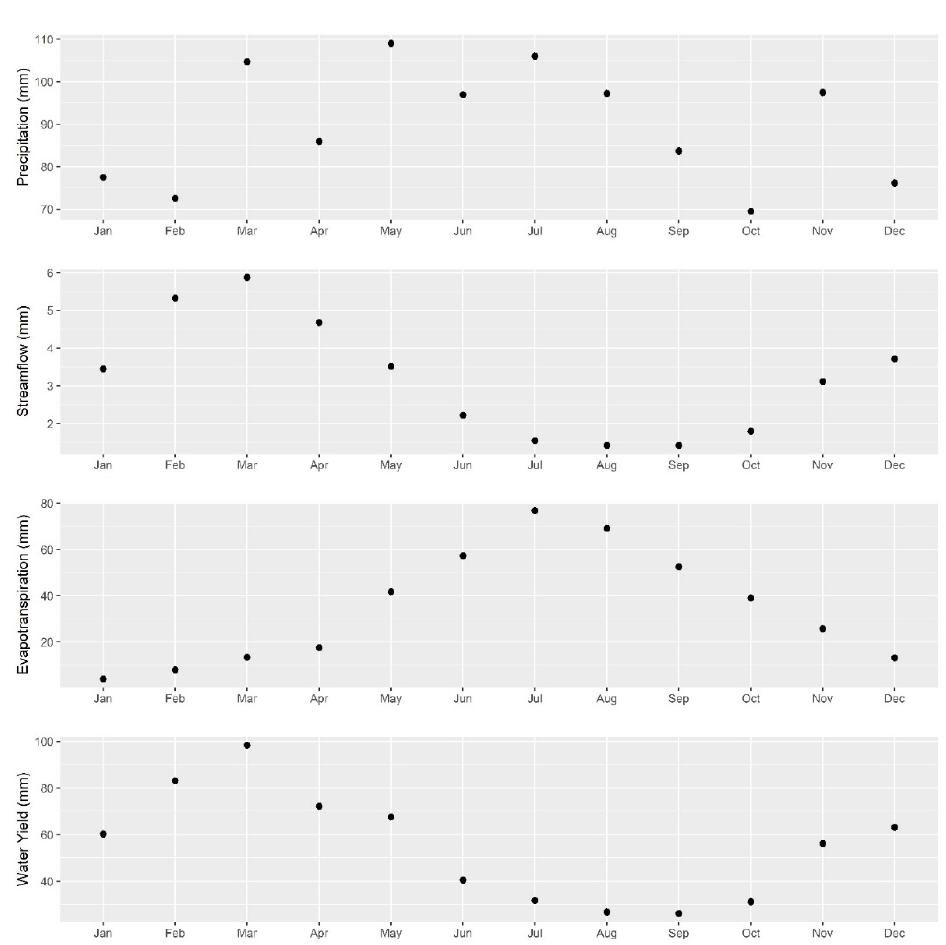
Figure A1. Monthly average of hydrologic components for historical baseline of 1980–1999.